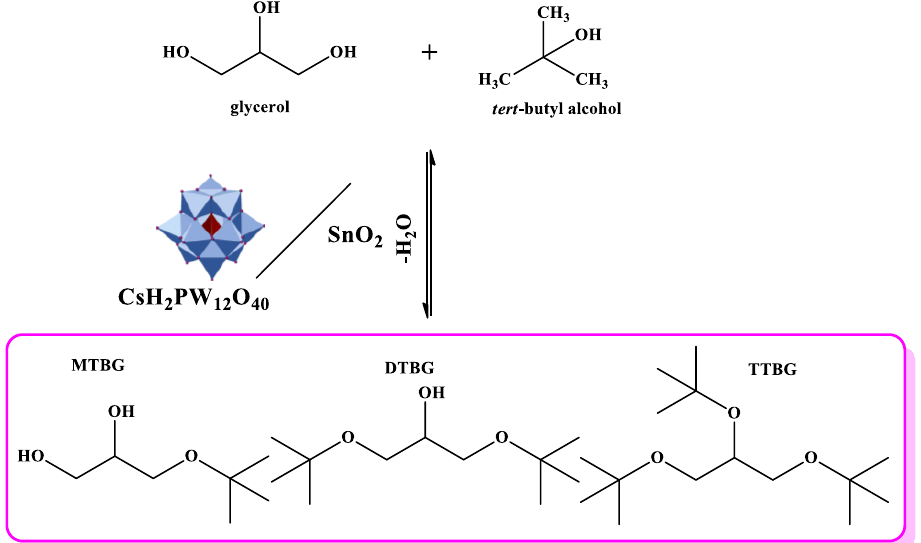
Figure 19. Etherification of glycerol with tert-butyl alcohol over CsH 2 PW 12 O 40 /SnO 2 (adapted from ref. [63]).